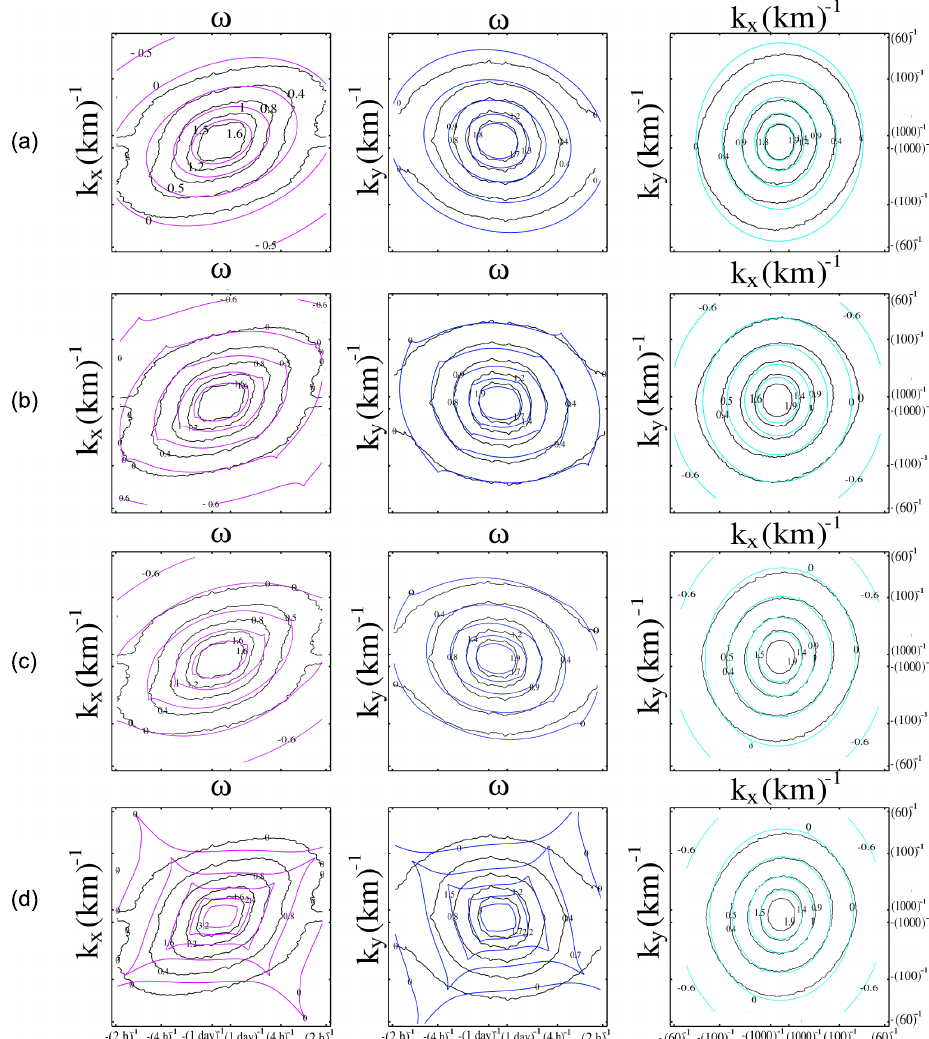
Fig. 2. Comparison of 2-D spectral densities from MTSAT data (in black) and a multivariate regression from theoretical P I ( k ,ω) given by Eq. (18) (in colour). The 2-D subspaces (left to right) are ( ω , k x ) , ( ω , k y ) and ( k x , k y ) . The ranges are ω from (2h) − 1 to (277h) − 1 ; k x from (60km) − 1 to ( ≈ 13000km) − 1 and k y from (60km) − 1 to ( ≈ 8000km) − 1 . (a) With imposed H wav =0, which corresponds to the purely turbulent case (with H tur = H − H wav , H =0.26 ± 0.05, s φ = 2 . 88 ± 0 . 01). The other parameters are V w = 41 ± 3kmh − 1 ; τ w = L e /V w ≈ 20 ± 1 days; a ≈ 1 . 2 ± 0 . 1; s I ≈ 3 . 4 ± 0 . 1; P 0 = 2 . 8 ± 0 . 2 ◦ , C 2 km 2 h; µ x ≈ − 0 . 3 ± 0 . 1; ( v x ≈ − 12 ± 4kmh − 1 ); µ y ≈ 0 . 10 ± 0 . 08; and ( v y ≈ 4 ± 3kmh − 1 ). Hence, σ = 0 . 95 ± 0.03. (b) H wav =0.17 ± 0.04 (best-fit value) and nondimensional wave speed v wav =1.0 ± 0.8. (c) Fit from Eq. (18) with ˜ g wav from Eq. (19). H wav =0.08 ± 0.04 and v wav = 1 . 4 ± 0 . 8. (d) Same parameters as (a) , but with imposed H wav =